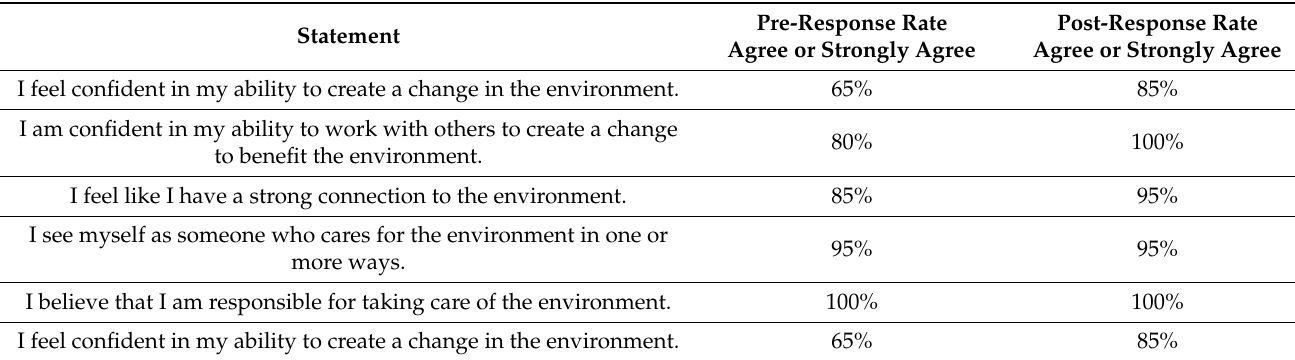
Table 4. Teacher environmental literacy identity question